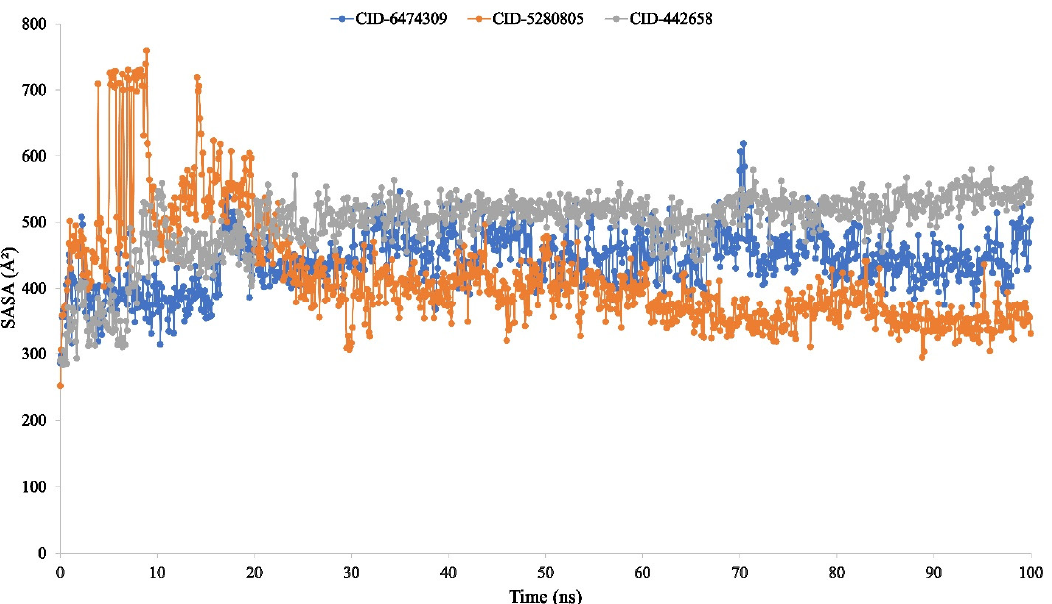
Figure 10. The solvent-accessible surface area (SASA) of the protein–ligand interaction compounds was calculated from the 100 ns simulation interaction diagram. The selected three ligands compound 4,5-di- O -Caffeoylquinic acid (CID-6474309), rutin (CID-5280805), and schaftoside (CID-442658) in association with the selected protein are depicted by green, orange, and grey, respectively.